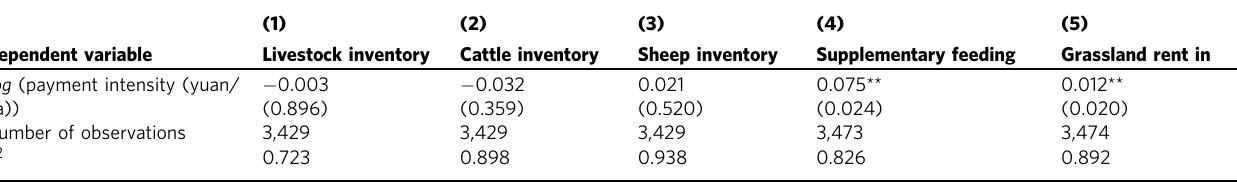
Table 5 Estimated impacts of the Grassland Ecological Compensation Program (GECP) on herder behavior: household